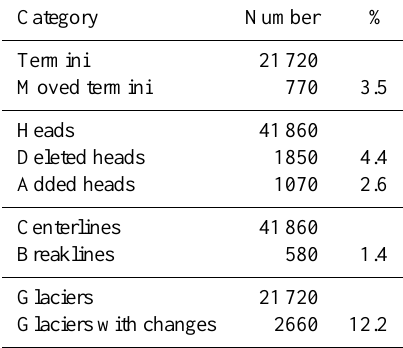
Table 2. Manual changes attributed to individual error categories. Percentages are relative to the total of each category (e.g., deleted heads vs. total